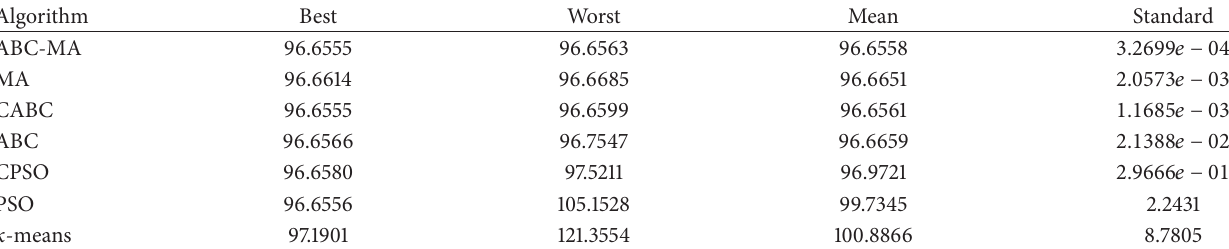
Table 3: Results obtained by the algorithms for 20 different runs on Iris data.